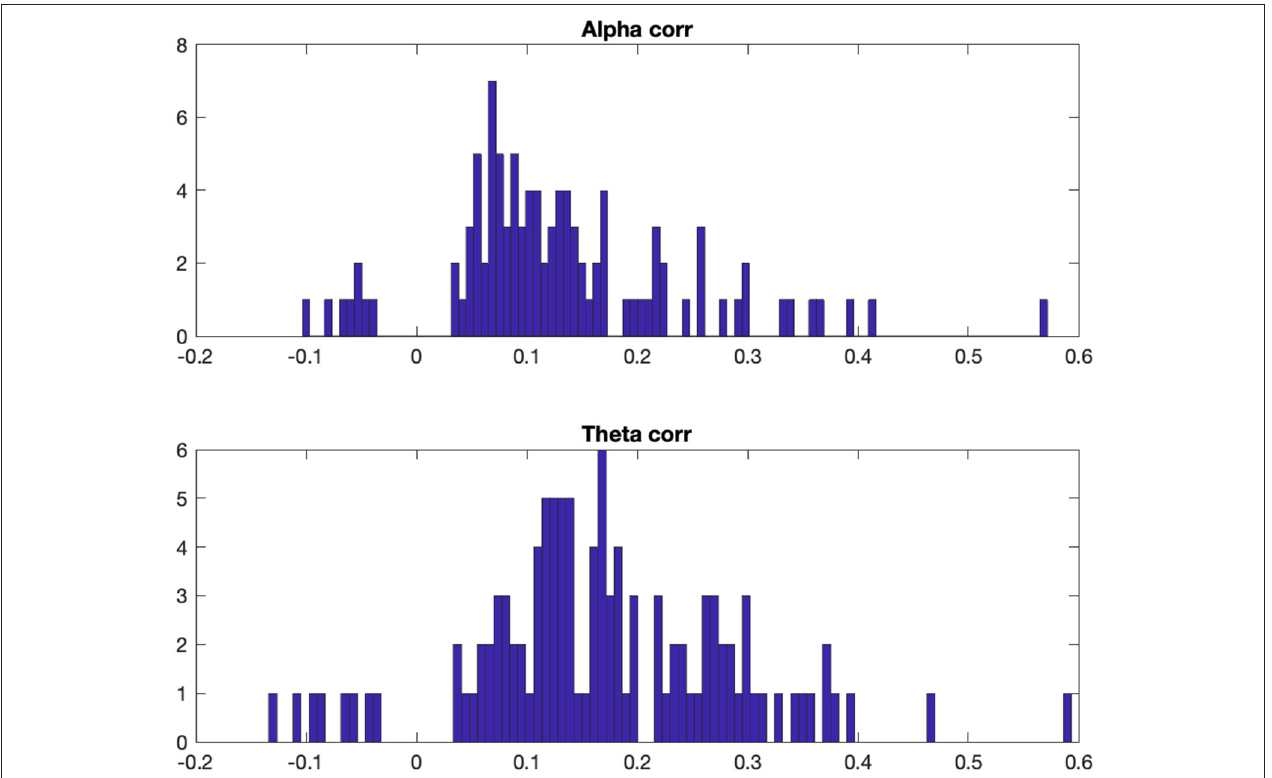
FIGURE 6 | Frequency distribution of individual (significant) Pearson’s correlation coefficients for alpha (upper row) and theta (lower row) fraction power measured at MP1 and